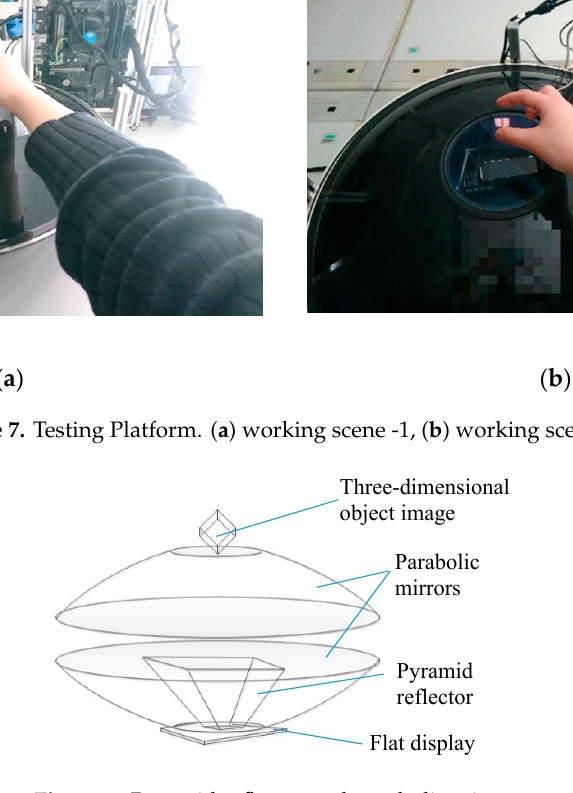
Figure 7. Testing Platform. ( a ) working scene -1, ( b ) working scene -2.